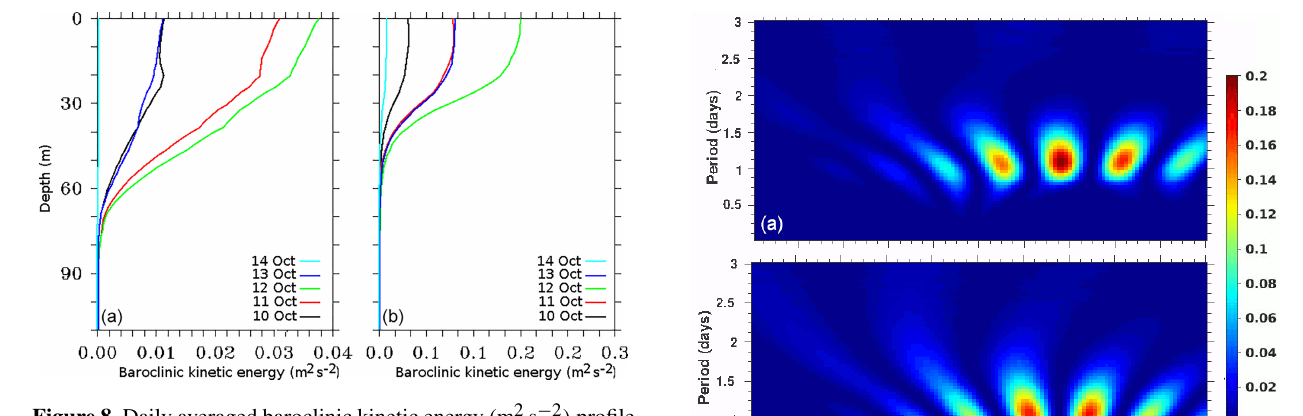
Figure 8. Daily averaged baroclinic kinetic energy (m 2 s − 2 ) profile at the on-track (a) and off-track (b) locations as marked with stars in Fig. 2.